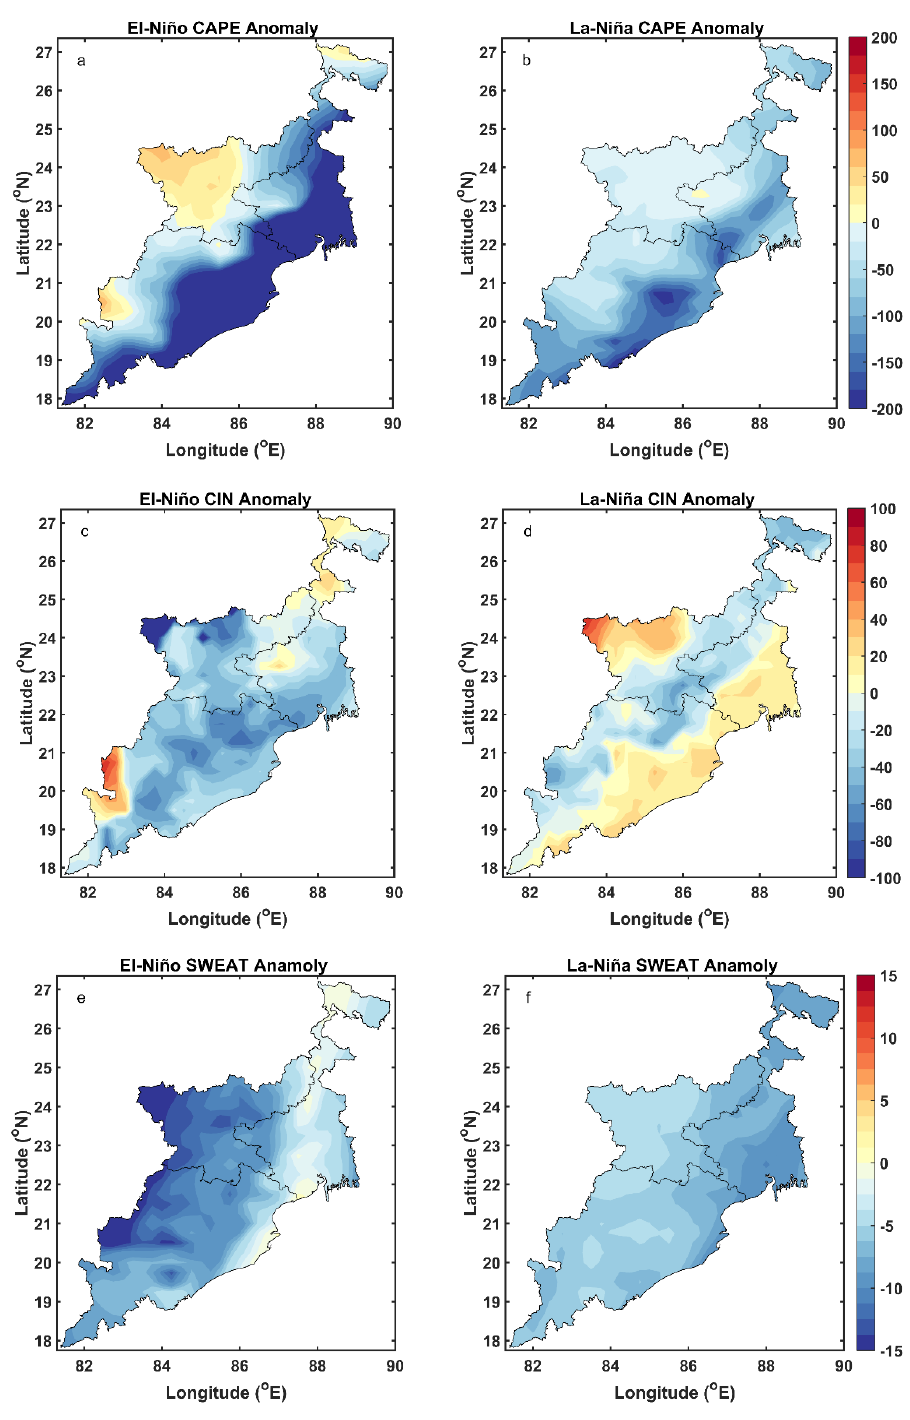
Figure 5. Anomalies of CAPE ( a ) El-Niño, ( b ) La-Niña (first row) CIN ( c ) El-Niño, ( d ) La-Niña (second row), and SWEAT ( e ) El-Niño, ( f ) La-Niña (third row) during the pre-monsoon season. The CIN values were higher during the La-Niña period. Odisha and West Bengal showed higher CIN values in the La-Niña years, with the highest values observed in the coastal areas of Odisha (~500–650 J/Kg), West Bengal (~550–650 J/Kg), and northern parts of Odisha. Over Jharkhand, the CIN values were higher during La-Niña (~350–500 J/Kg), but the magnitude of the CIN values was smaller than Odisha and West Bengal. The CIN